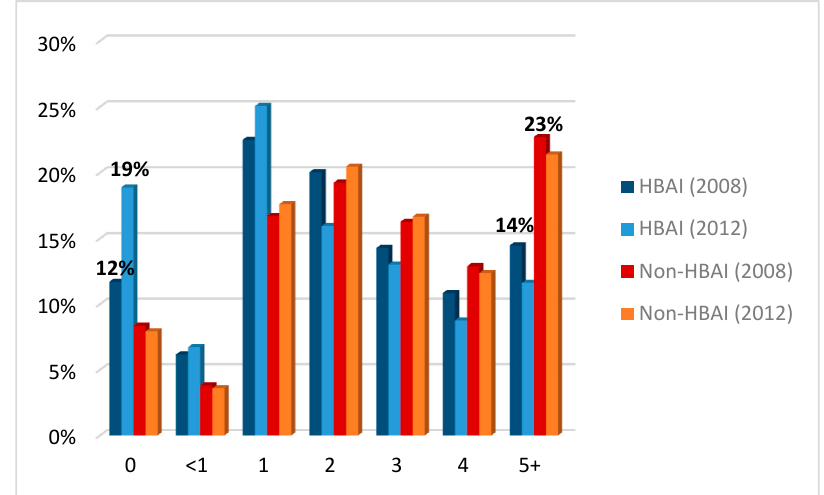
Figure 1. Percentage of individuals from HBAI (households below average income.) and non-HBAI by fruit and vegetables consumption (number of portions on the day prior to the interview). Source: computed by the authors based on SHeS (2008 and 2012)—weighted data.